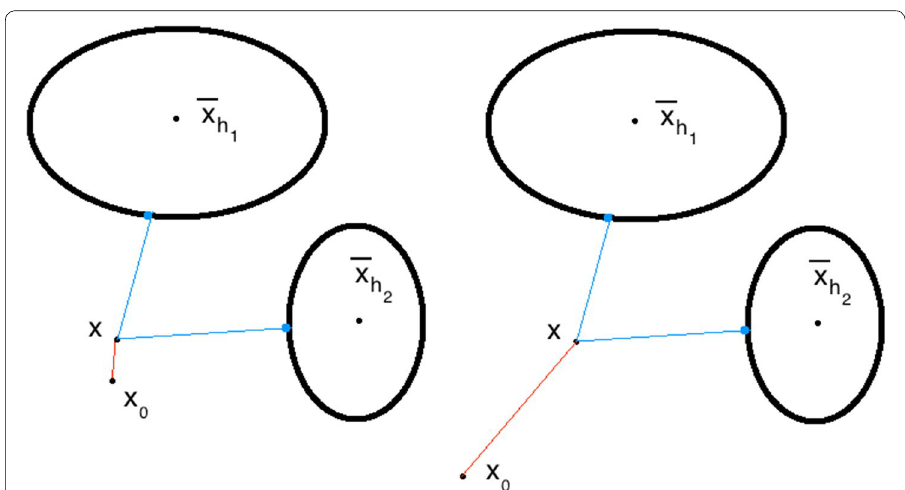
Fig. 3 The two possible situations, after the centers’ perturbation, when x is closer to a point x o of the retained set in the first comparison. Left: the points x and x o are joined to form a new cluster; right: x and x o are moved to